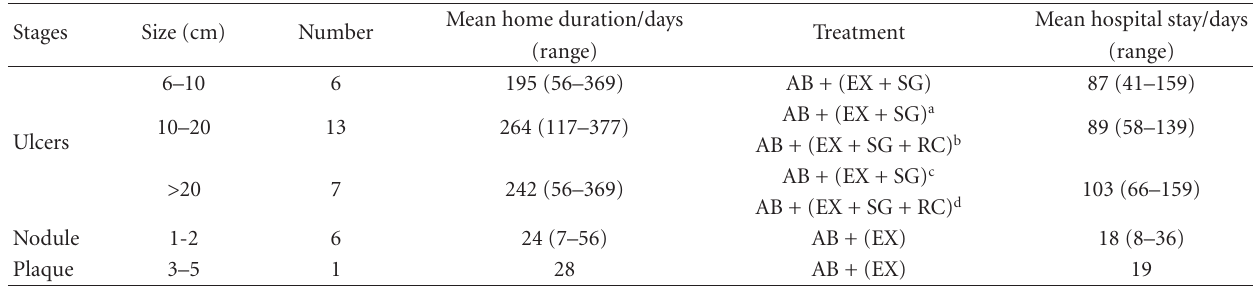
Table 2: Buruli ulcer patients’ medical history ( n = 33).